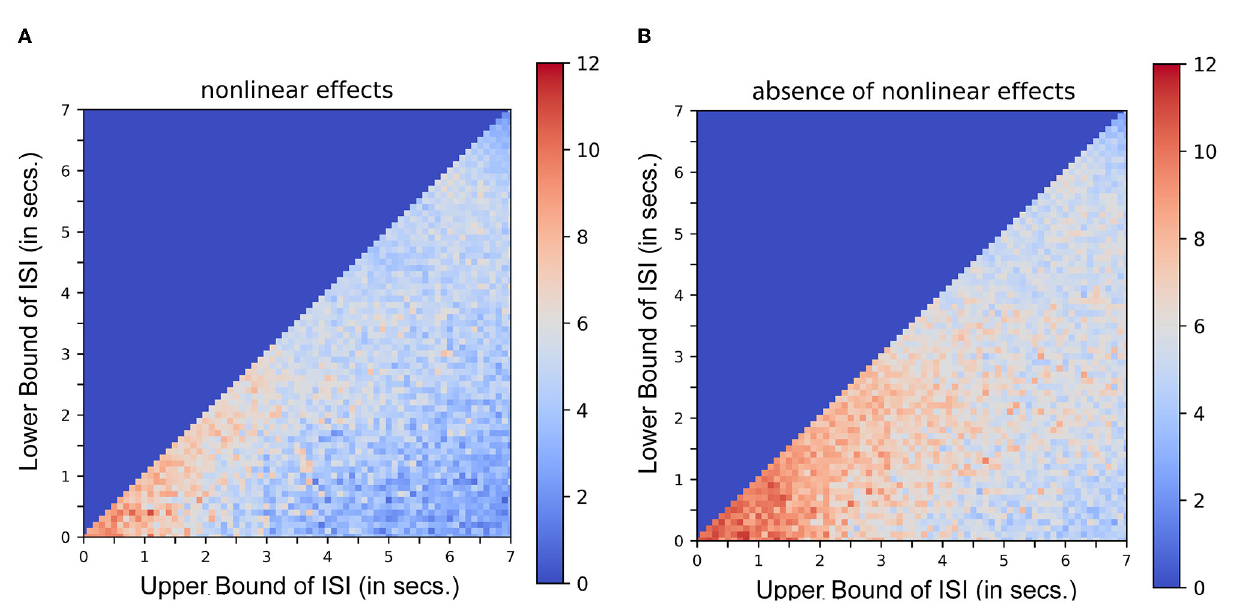
FIGURE3 Nonlinear interactions in stimulus sequences. Integrated response over a simulated 441s single event stimulus sequence as a function of lower and upper bounds of ISI. Each dot pixel represents the magnitude of integrated response in units. (A) Response in presence of nonlinear effects. (B) Response in absence of nonlinear